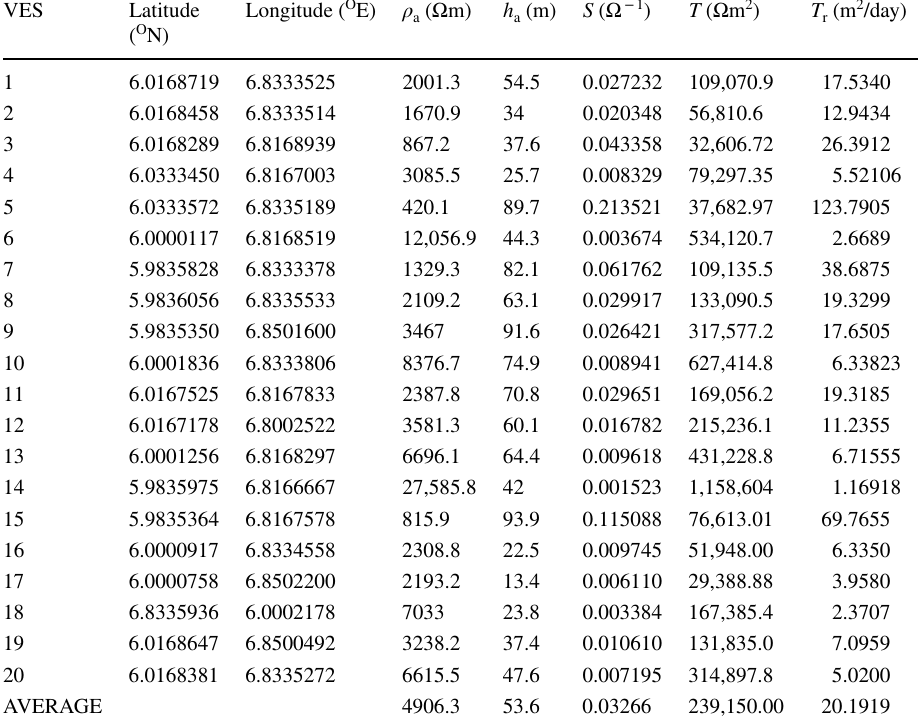
Table 2 Aquifer parameters of the location